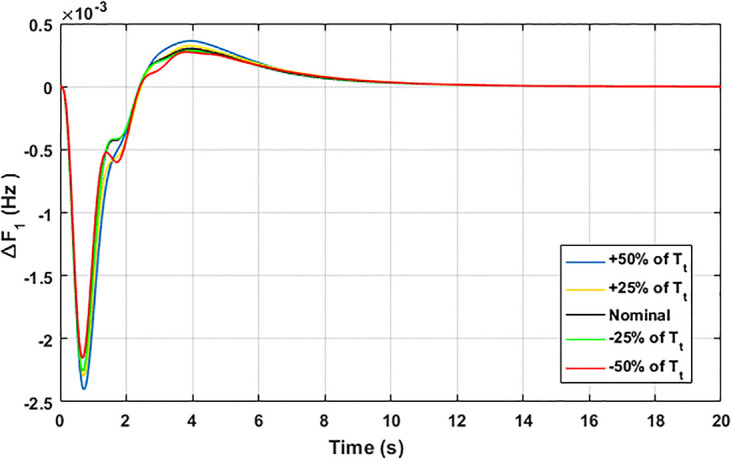
Results for variation in Tt with ΔF1.